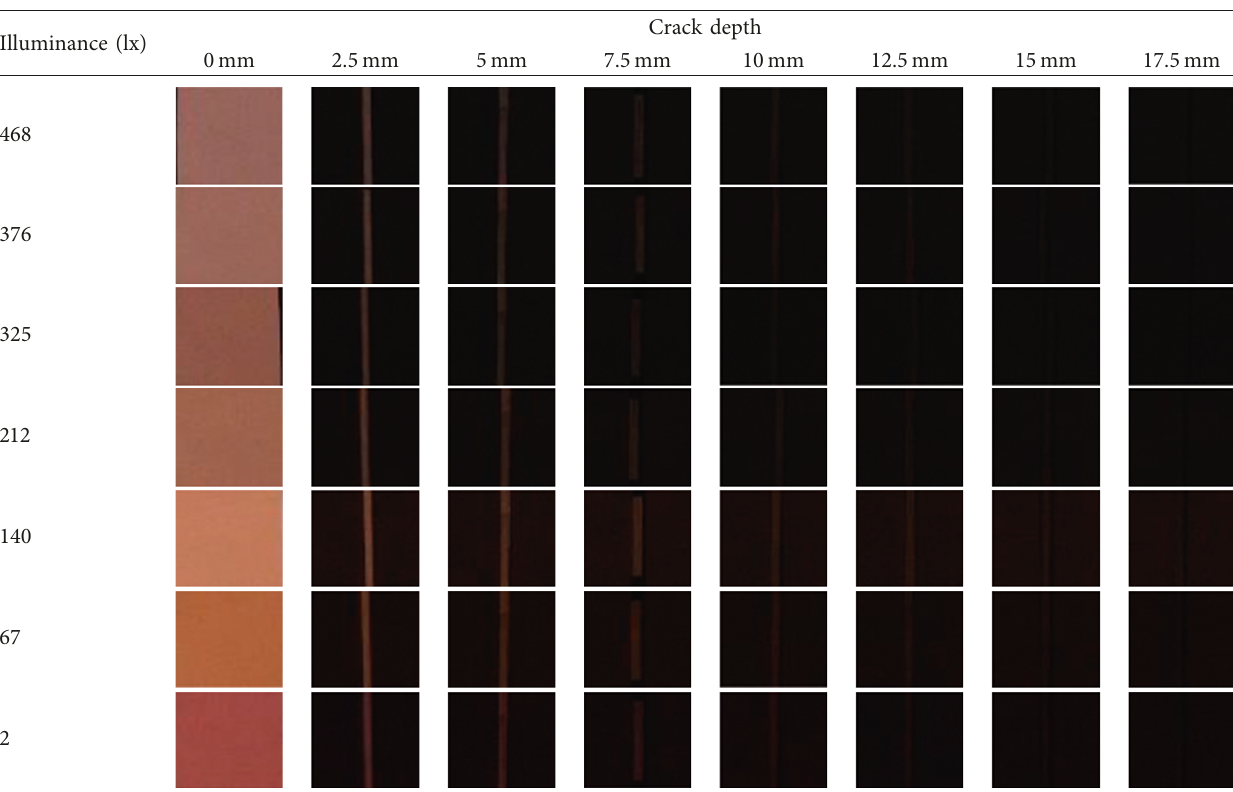
Table 7: Experimental images of Figure